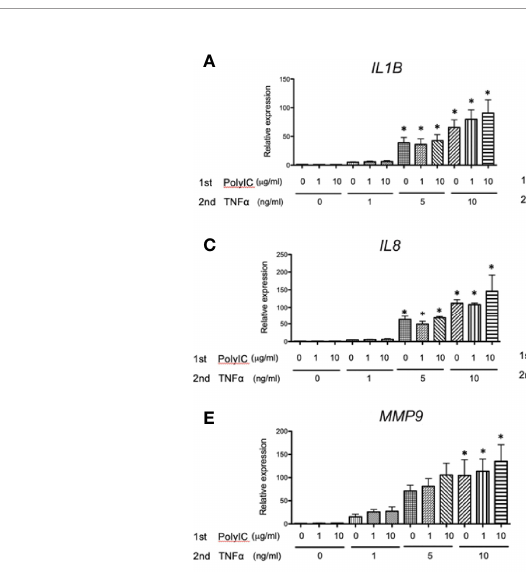
FIGURE 4 | Gene expressions after PolyIC – WD – TNF at different concentrations of Poly (I:C) and TNF a . MRC-5 cells were initially treated with Poly (I:C) for 24 h and were then washed and rested for 24 h before being secondarily treated with TNF a for another 24 h. (A – E) Effect of different concentrations of Poly (I:C) (0, 1, 10 µg/ ml) and TNF a (0, 1, 5, 10 ng/ml) on gene expressions of IL1B , IL6 , IL8 , MMP8 , and MMP9 . Secondary treatment to TNF a dose-dependently induced these gene expressions. Preexposure to Poly (I:C) did not affect TNF a -induced IL1B , IL8 , MMP8 , and MMP9 gene expressions [PolyIC (0 µg/ml) – WD – TNF (10 ng/ml) vs. PolyIC (10 µg/ml) – WD – TNF (10 ng/ml)]. (F) Preexposure to Poly (I:C) (10 µg/ml) and secondary treatment of MRC-5 cells with TNF a (10 ng/mL) did not affect the fi brosis- related genes; ACTA2 , COL1A1 , POSTN , and TGFB1 . N = 4. Values with * were de fi ned signi fi cant when compared to (-)-WD-(-) while *above bar were signi fi cant between two variables.